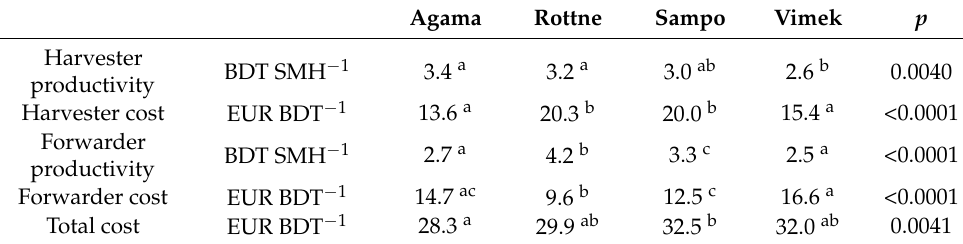
Table 3. Machine productivity and cost (mean values).